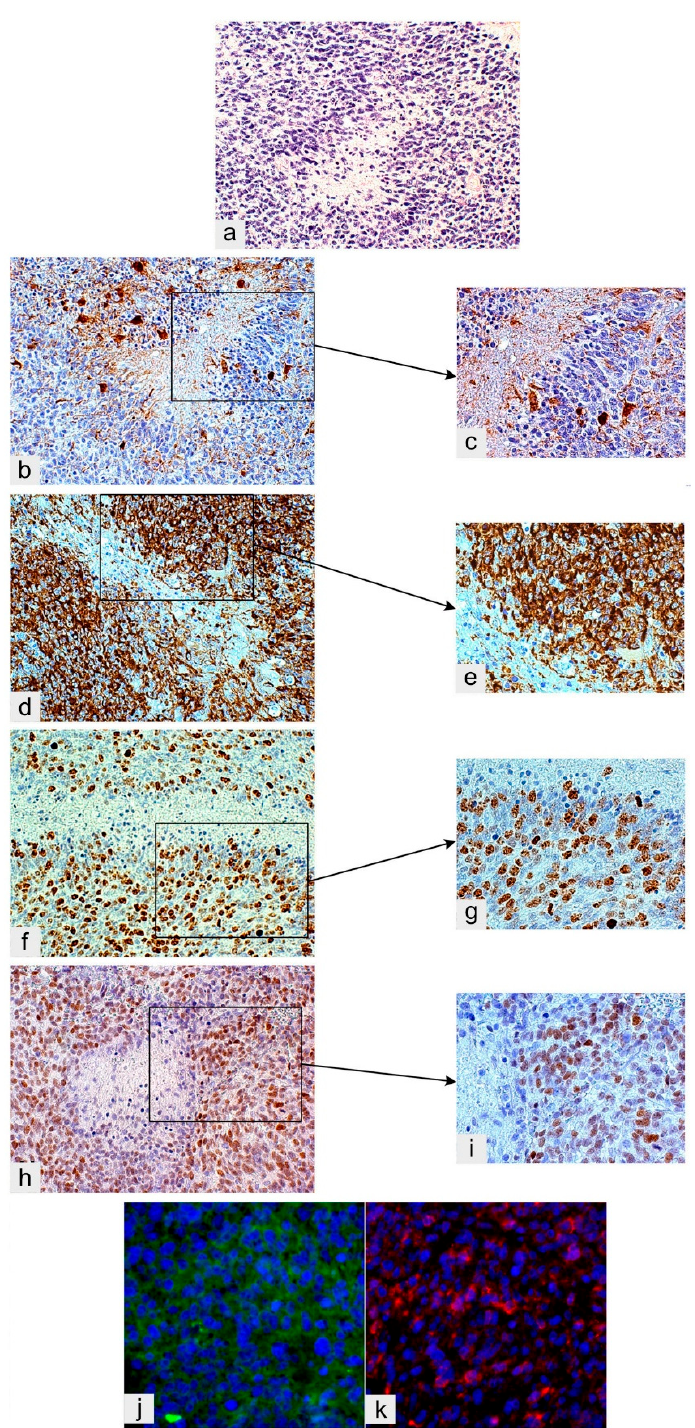
Figure 3. Glioblastoma, IDH wild type. ( a ) Circumscribed necrosis in a hyperproliferative area; H&E, original magnification (OM) ×200. The hyperproliferative zone bordering necrosis is almost GFAP-negative; DAB, OM ×200 ( b ) and ×400 ( c ). The same area is highly Nestin-positive; DAB, OM ×200 ( d ) and ×400 ( e ). The same area shows a high Ki-67/MIB-1 labeling index; DAB, OM ×200 ( f ) and ×400 ( g ). The same area is highly Sox2-positive; DAB, OM ×200 ( h ) and ×400 ( i ). The same area is positive for Musashi-1, cryostat section, immunofluorescence (green) ( j ) and highly CD133-positive, cryostat sections, immunofluorescence (red), both OM ×400 ( k ). IDH, isocitrate dehydrogenase; H&E, hematoxylin and eosin; DAB, DAB, 3,3 ′ - Diaminobenzidine [49].